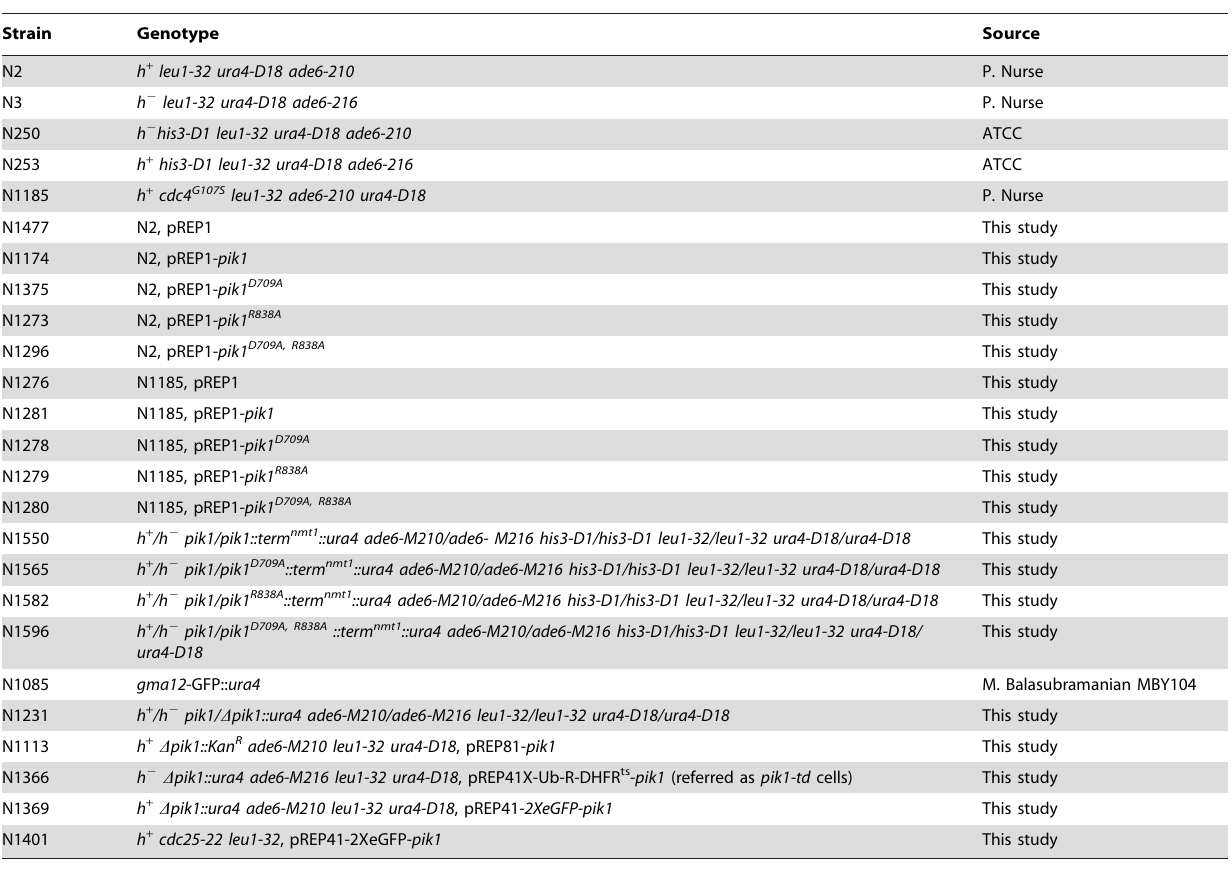
Table 1. Schizosaccharomyces pombe strains.